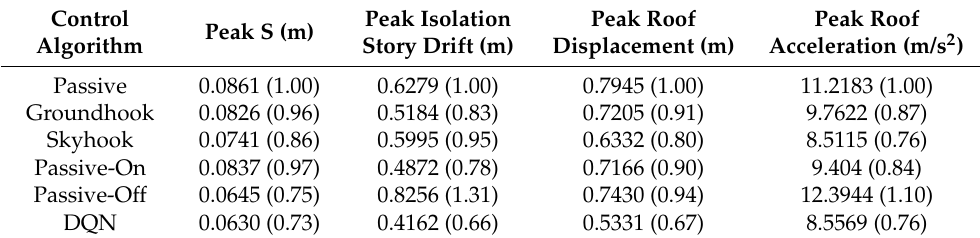
Table 4. Comparison of peak responses according to control algorithms